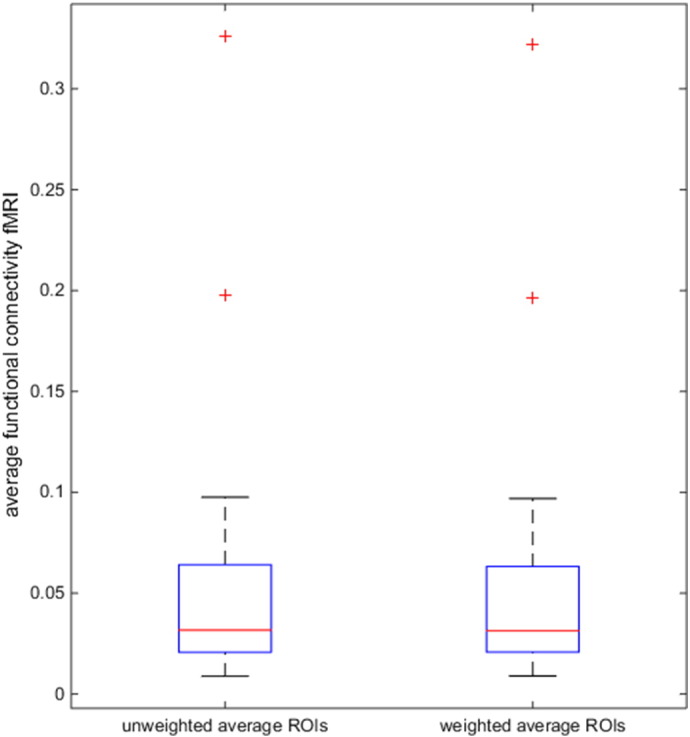
Effect of the order of correction for noise and averaging over an ROI (fMRI). We show the average fMRI functional connectivity values for both orderings i) first correction for noise followed by a weighted average over voxels in ROI, ii) first computing a weighted average over voxels followed by a correction for noise. Noise consisted of average white matter signal, average cerebrospinal fluid signal, motion during the scanning and polynomial correction. From the boxplots it can be clearly observed that the ordering did not significantly affect the results.